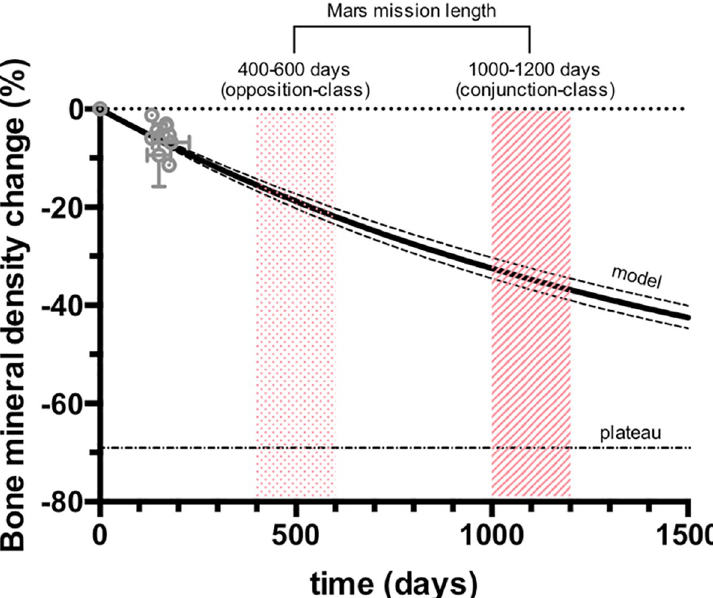
Fig 1. Bone mineral density change (%) at the femoral neck of astronauts versus duration of spaceflight. Grey dots represent experimental data obtained in previous missions as measured by dual-energy x-ray absorptiometry (DXA). Two different potential human missions to Mars are highlighted: (i) opposition-class, with a duration of 400–600 days (area with red dots) and (ii) conjunction-class, with a duration of 1000–1200 days (area with red lines). The predictive model is represented by the solid, black line, with the 95% confidence interval limits plotted in dashed, black lines, and the plateau by the dot-dashed, black line. A comparison with the (unphysical) linear model can be found in S1–S3 Figs.